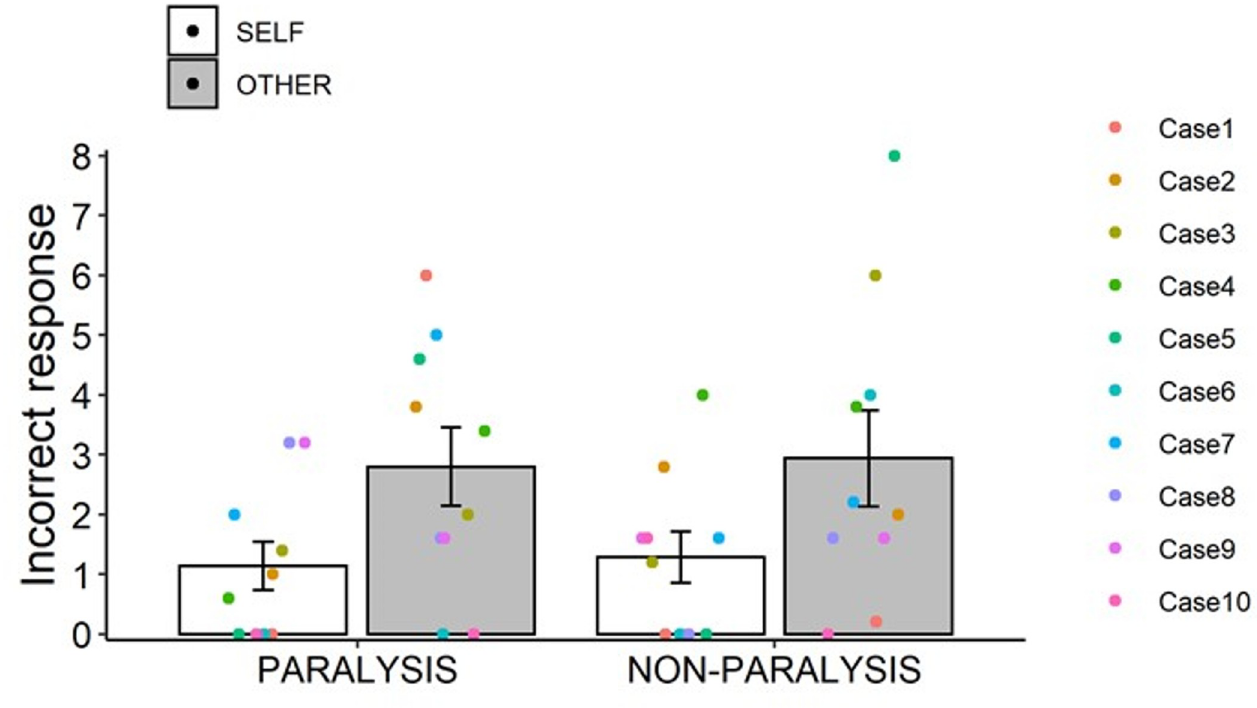
Fig 4. Incorrect responses (i.e., misattributions) on self-other judgments between the paretic and non-paralyzed upper limbs scores in post-stroke patients. In the SELF condition, incorrect responses indicated the other-attribution of self-movement, i.e., participants judged their own movement as an other’s movement. In the OTHER condition, incorrect responses indicated the self-attribution of an other’s movement, i.e., participants judged an other’s movement as their own movement. Error bars indicate standard errors.